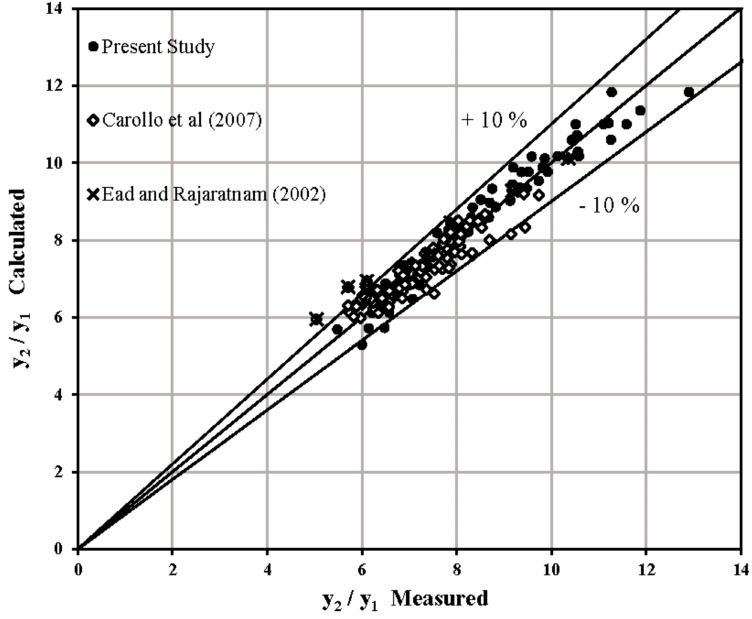
Figure 5. Comparison between all the y 2 / y 1 values measured and those calculated by Equation (12).